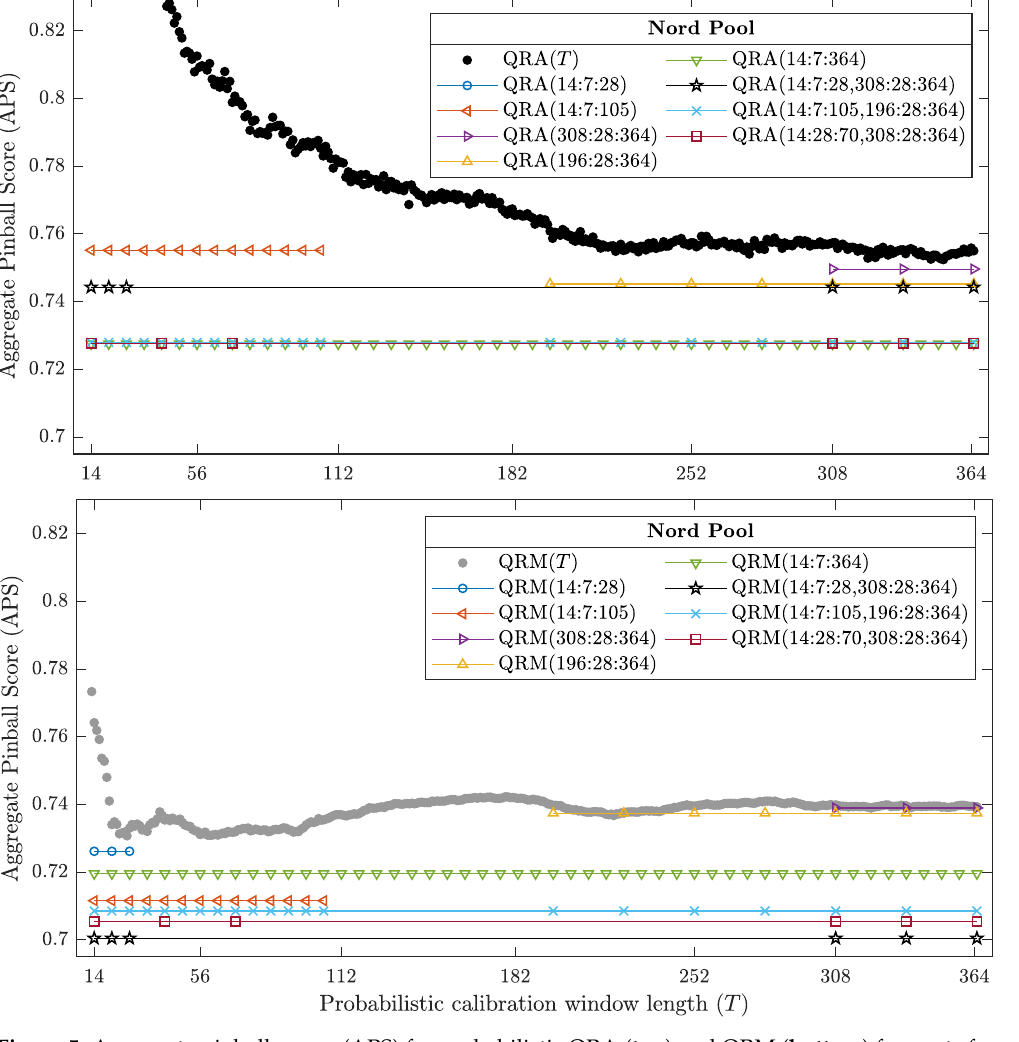
Figure 5. Aggregate pinball scores (APS) for probabilistic QRA ( top ) and QRM ( bottom ) forecasts for the Nord Pool dataset. Filled circles refer to individual probabilistic calibration window lengths and lines with symbols indicate window lengths selected for averaging